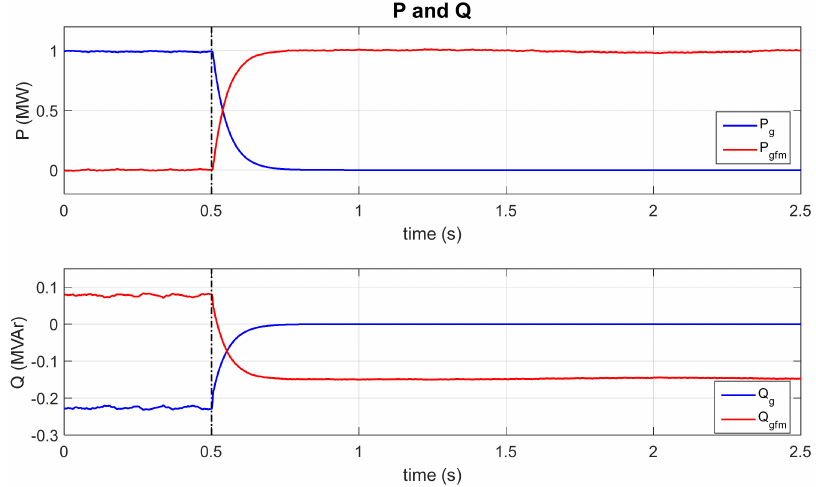
Figure 21. Active and reactive powers during the transition to islanded